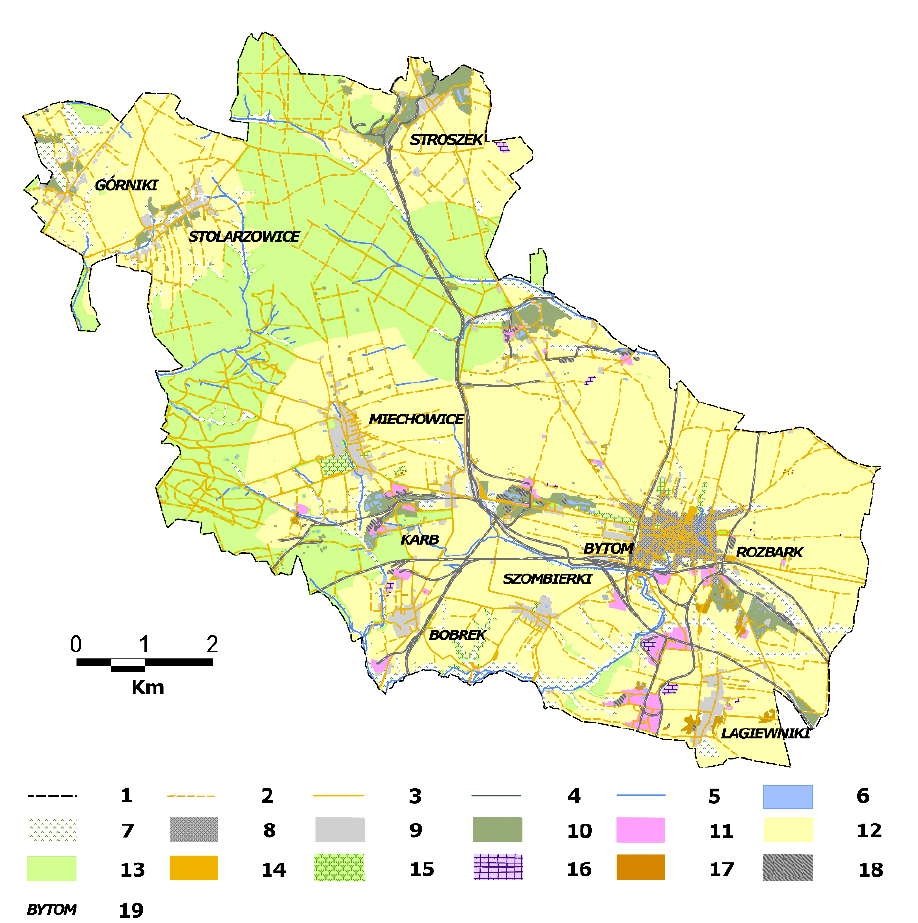
Figure 3. The land use of the area of Bytom in 1883 (Sourced by authors on the basis of Herausgegeben von der Preussischen Landesaufnahme 1883. Reichsamt für Landesaufnahme., 1: 25,000, sheet: 3309 Beuthen; 3308 Hindenburg; 3257 Broslawitz; 3258 Tarnowitz; Berlin). Explanations: 1—current city border; 2—dirt roads; 3—paved roads; 4—railway lines; 5—water courses; 6—water reservoirs; 7—meadows; 8—dense development; 9—dispersed development, cemeteries, railway areas; 10—ore and zinc extractions and post-extractions wastelands; 11—industrial areas; 12—arable fields, fallow lands; 13—forests and trees; 14—road areas; 15—parks, squares, and lawns; 16—quarries; 17—gravel pits, clay pits and sand pits; 18—dumps; 19—topographic